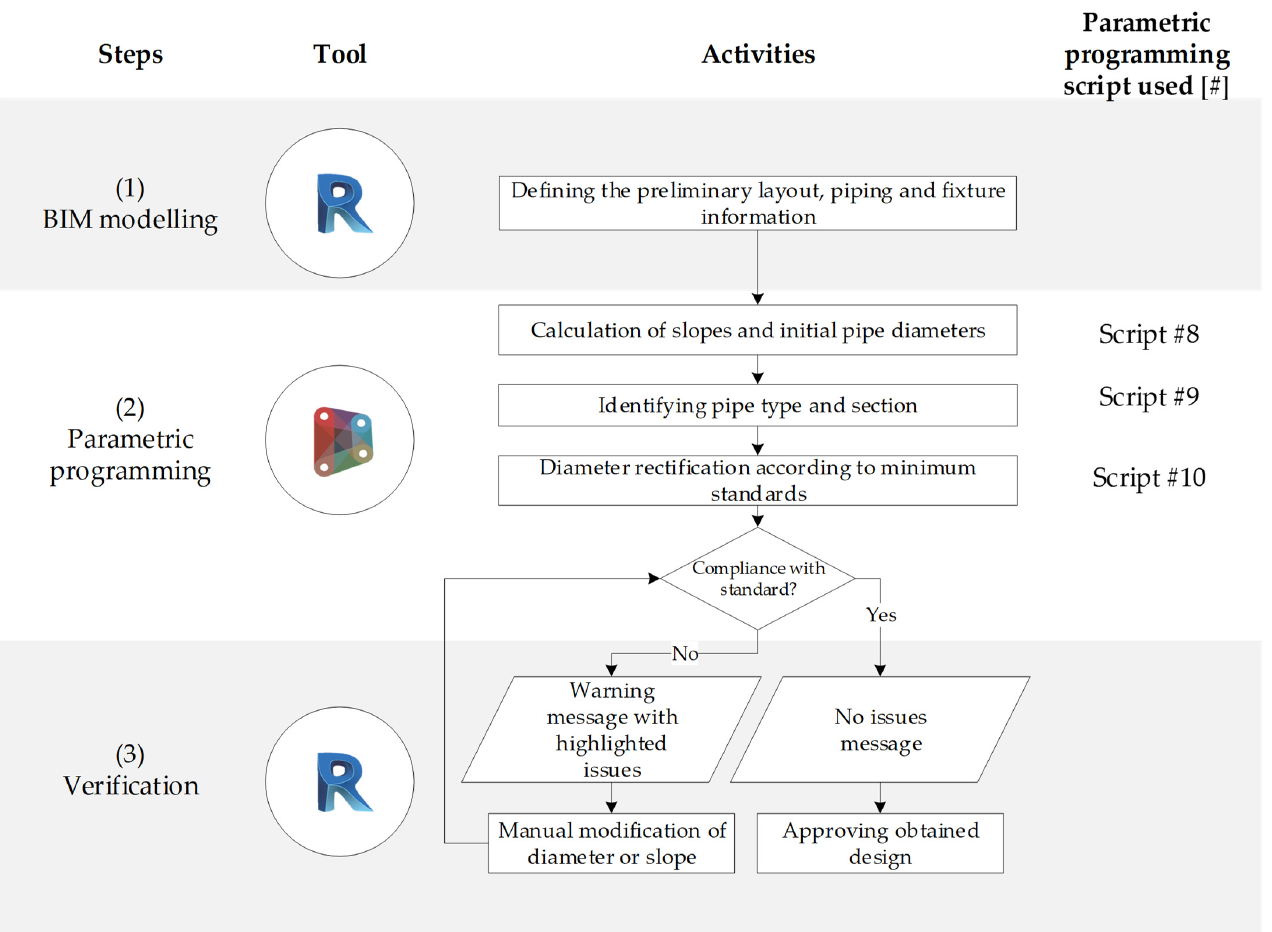
Figure 14. Processes for sewerage system verification organised into three steps: (1) BIM modelling, (2) parametric programming and (3) verification. All the scripts are presented in the Appendix A.